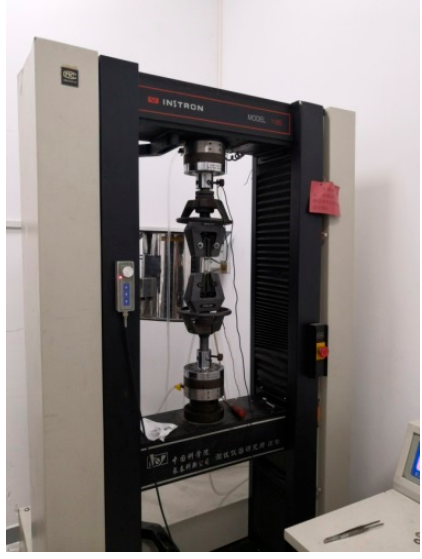
Figure 1. Diagram of quasi-static experimental equipment.